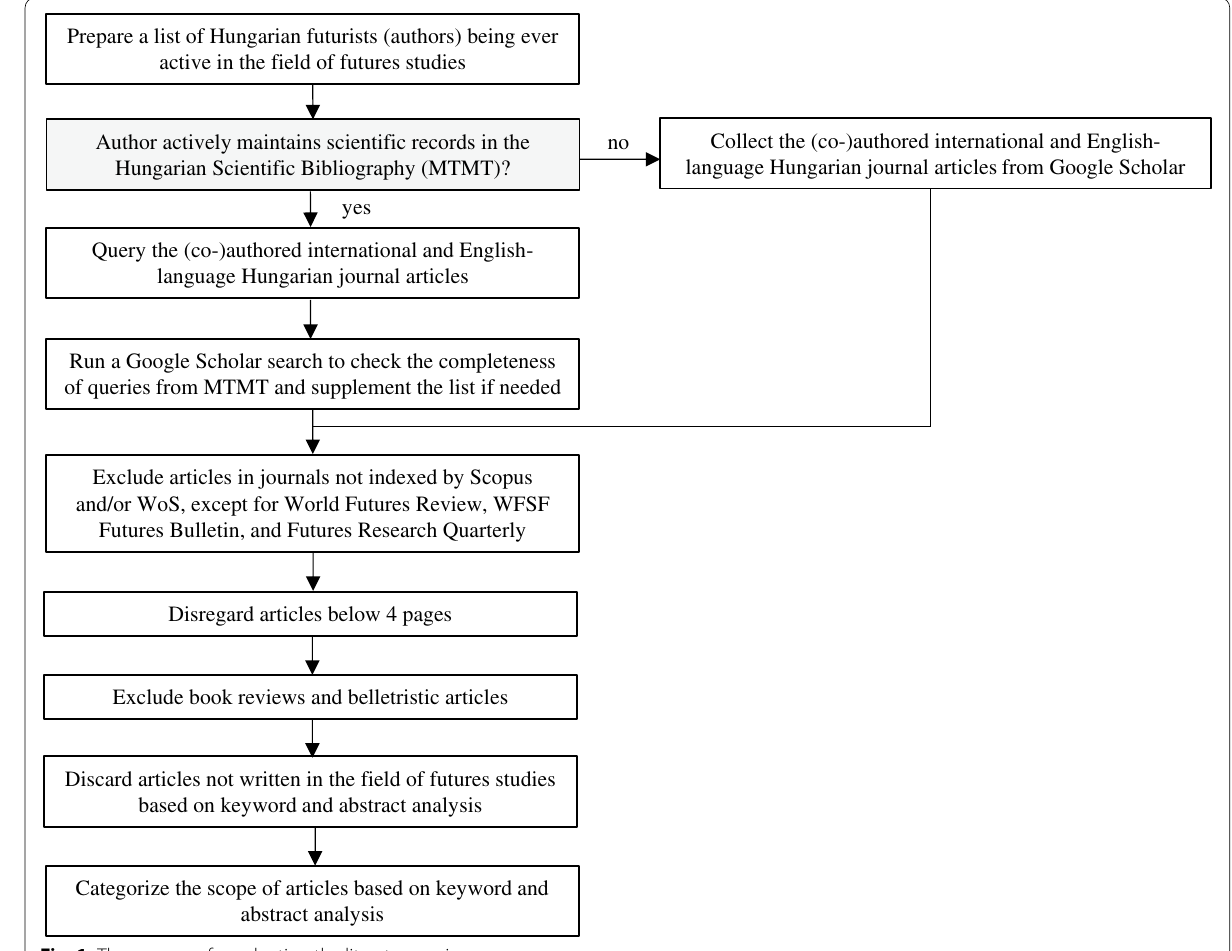
Fig. 1 The process of conducting the literature